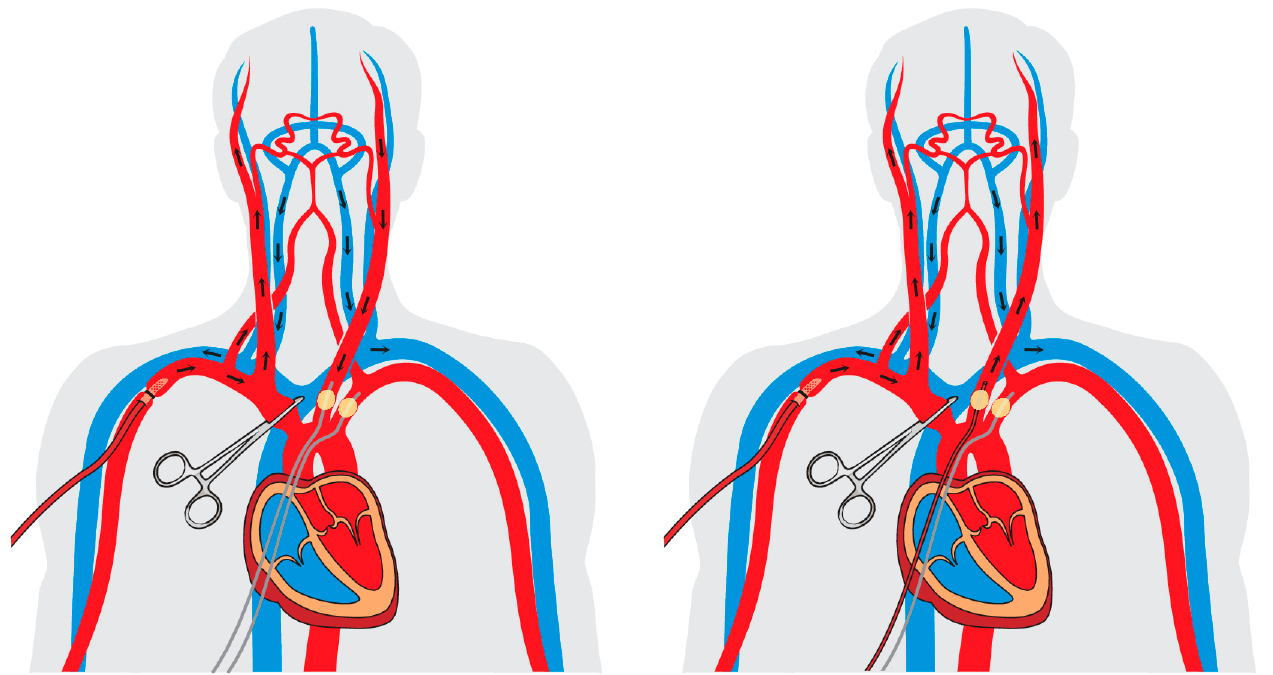
Figure 3. Performance of unilateral ( left ) and bilateral antegrade cerebral perfusion ( right ).